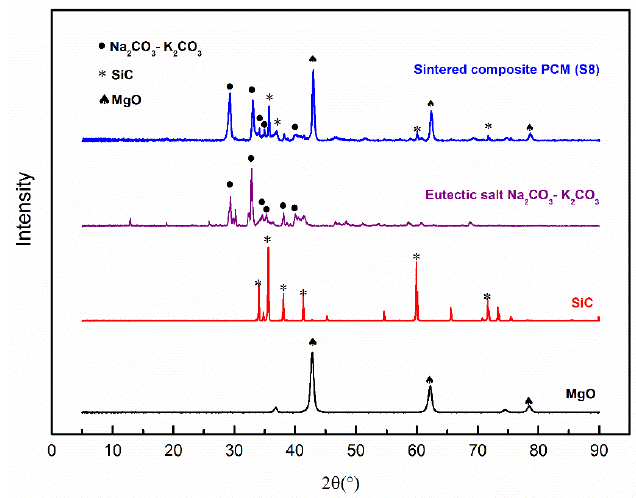
Figure 6. XRD Patterns of the composite PCM and individual components.